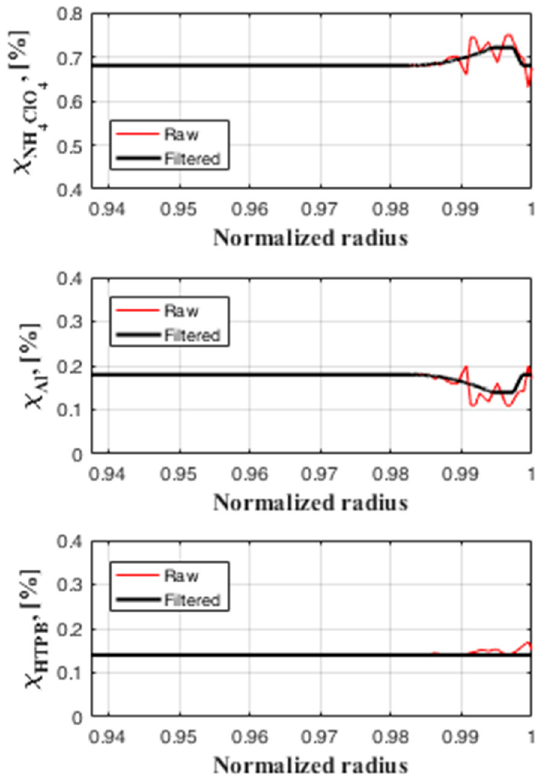
Figure 13. Packing result for the bi-dispersed propellant with wall boundary conditions applied in the x direction.